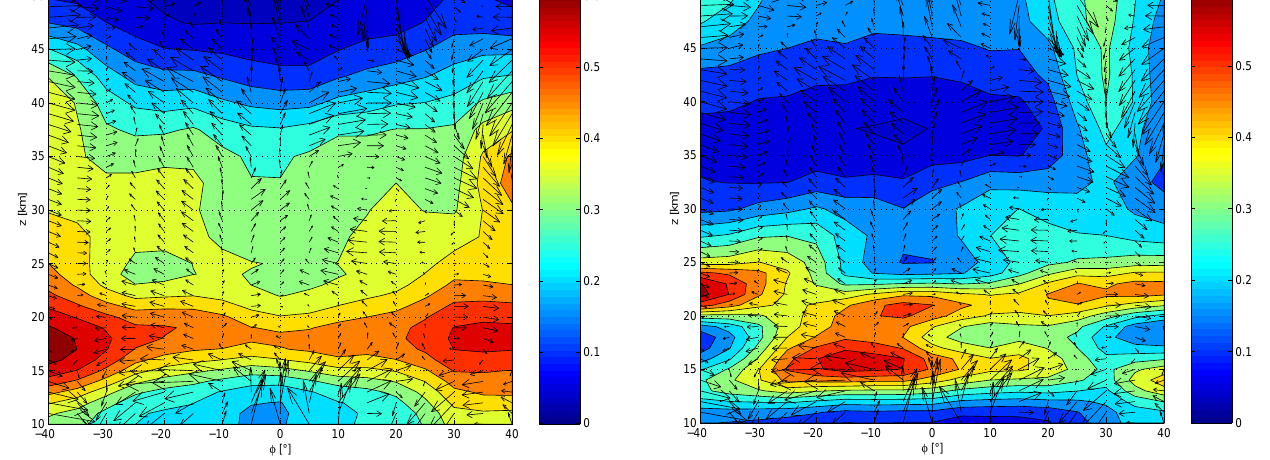
Fig. 3. Same as Fig. 2 but for mode radius r m . Fig. 4. Same as Fig. 2 but for ln ( σ )